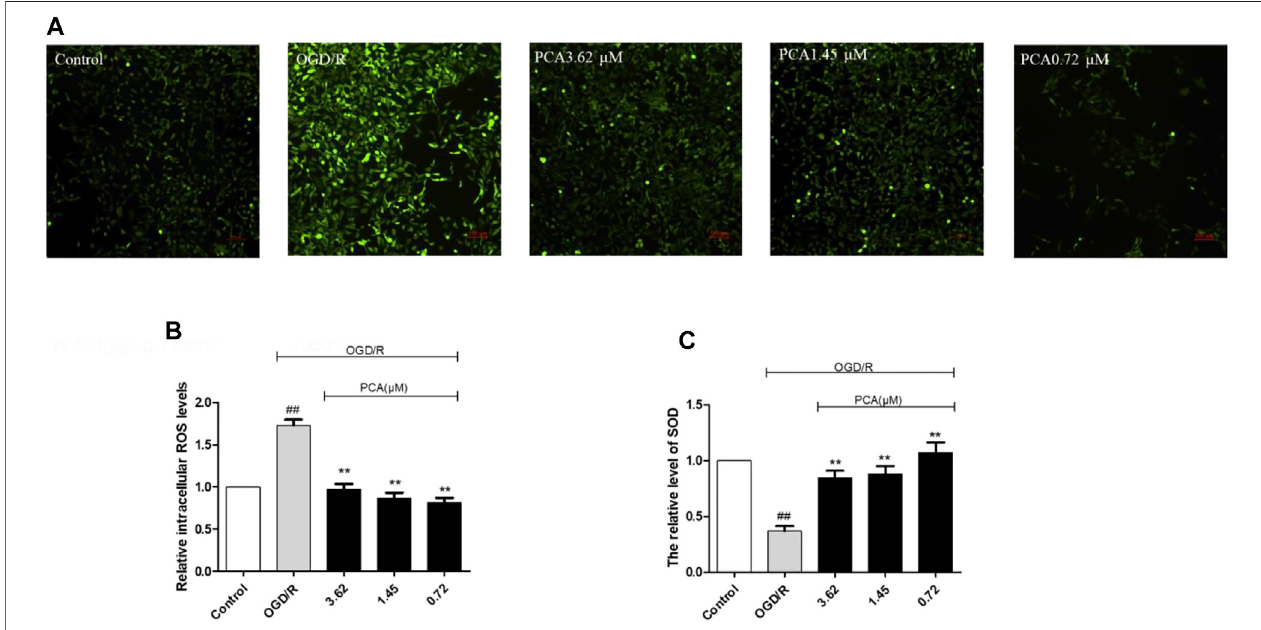
FIGURE3| PCAincreasedantioxidantactivityinOGD/RinducedHUVECs. (A,B) QuantitationofHUVECsROSlevelwasshown. (C) QuantitationofHUVECsSOD activity was shown. The values are expressed as the mean ± SD ( n = 3). ## p < 0.01 vs. Control, ** p < 0.01 vs. OGD/R.